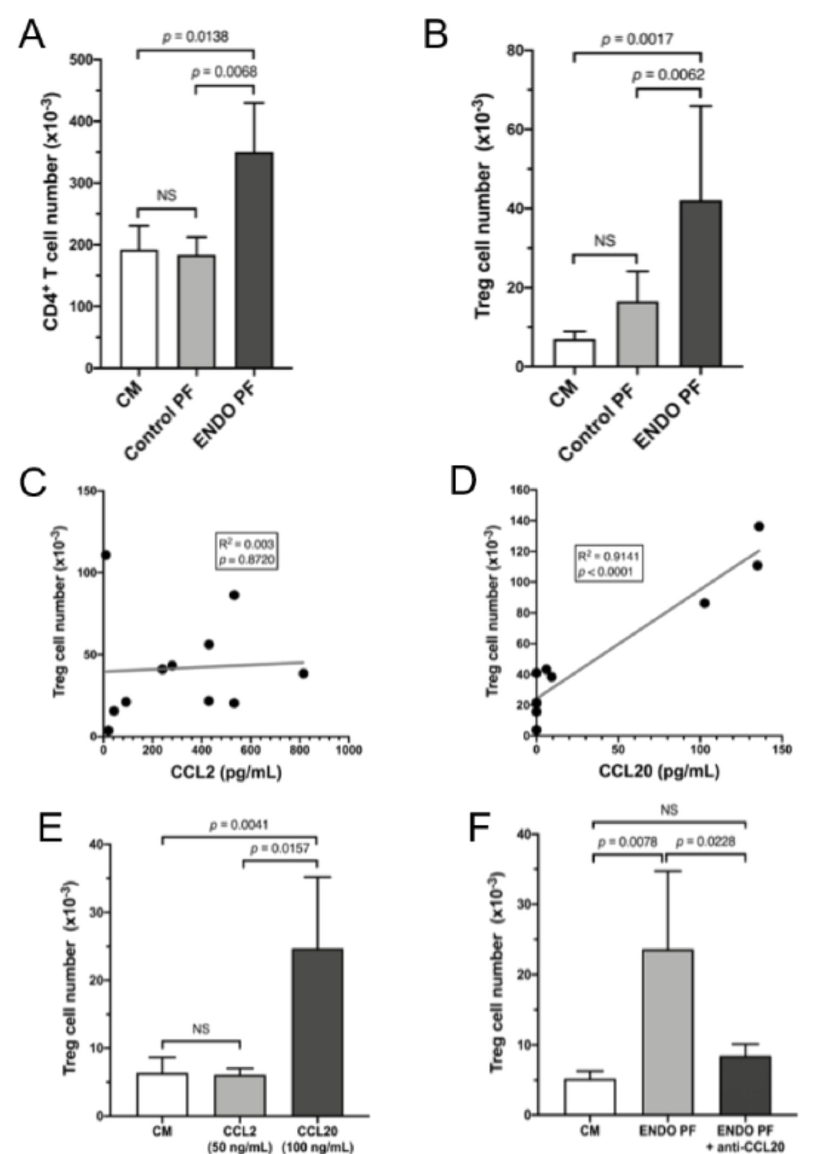
Figure 5. Demonstration of chemotactic activity of the peritoneal fluid from patients with endometrio- sis (ENDO PF) and control women (Control PF) for CD4 + and Treg cells and identification of CCL20 as a chemotactic factor responsible for attraction of Treg cells. Effect of control ( n = 4) and endometri- otic ( n = 5) peritoneal fluid on chemotaxis of CD4 + T ( A ) and Treg cells ( B ). Correlations between the peritoneal fluid concentrations of CCL2 ( C ) and CCL20 ( D ) and the chemotaxis of Treg cells. ( E ) Effect of human recombinant CCL2 and CCL20 on the chemotaxis of isolated Treg cells ( n = 4). ( F ) Effect of neutralizing anti-CCL20 antibody on the chemotactic activity of the peritoneal fluid from women with endometriosis ( n = 4). Cell chemotaxis was evaluated as described in the Material and Methods section and is expressed as the number of migrating cells. Culture medium alone (CM) served as a negative control. Each bar represents mean ± SD. Statistical significance between groups was computed by the one-way analysis of variance (ANOVA) for independent samples followed by post hoc Tukey’s multiple comparison test. Correlations between the tested variables were computed by a linear regression analysis. Correlation coefficients (R 2 ) and p -values are shown in the